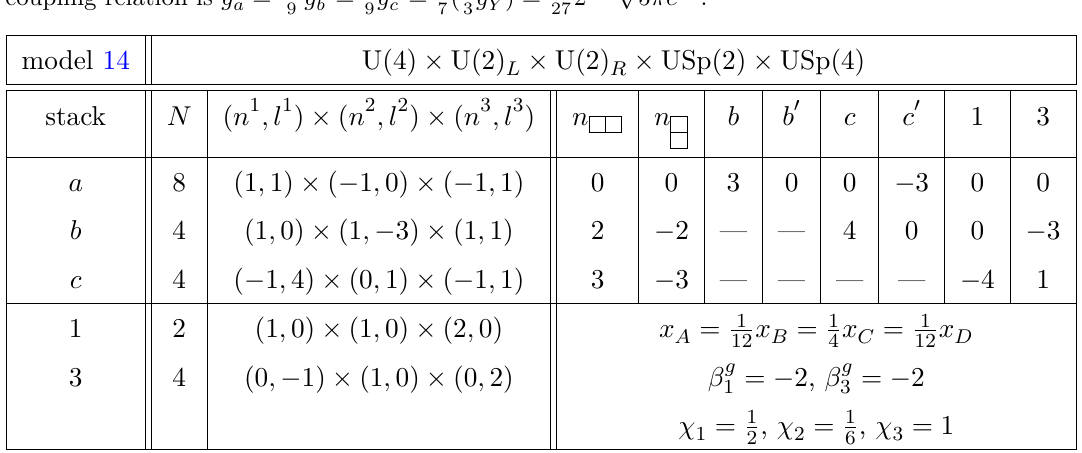
Table 14 . D6-brane configurations and intersection numbers of Model 14, and its MSSM